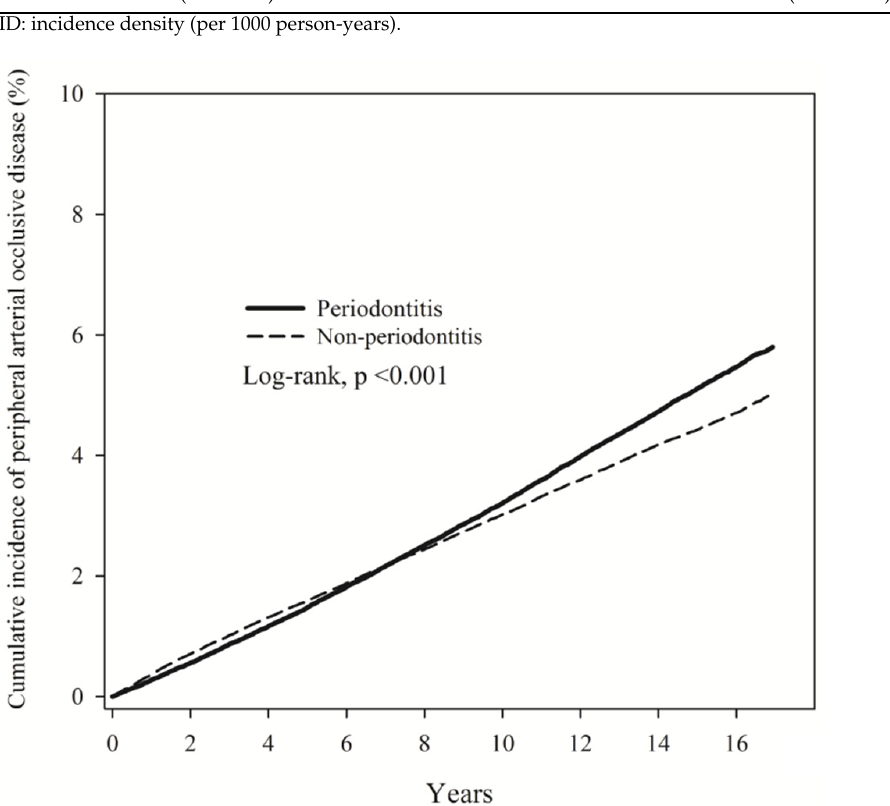
Figure 2. Kaplan–Meier curves of the cumulative proportions of PAOD in periodontitis and non- periodontitis patients. Table 3. Cox proportional hazard model analysis for risk of PAOD.